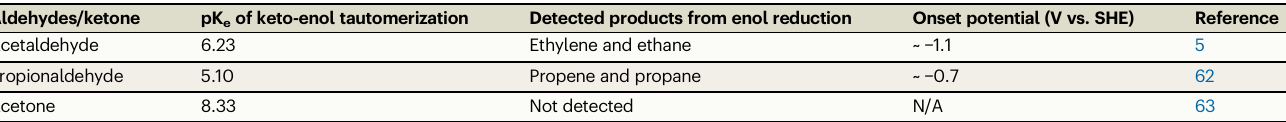
Table 1 | Summary of RDE-GC-MS, RRDE results, and pK e values for selected aldehydes and ketone ( − 1.2 V vs. RHE on Cu disk, 1600 RPM, 0.1 M